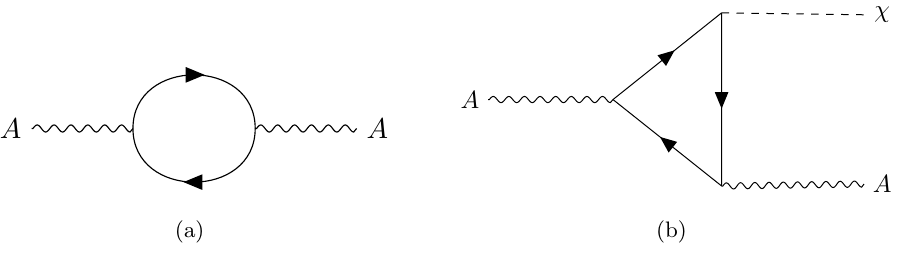
Figure 1 . One-loop diagrams contributing to the (cid:12)eld independent (a) and (cid:12)eld dependent (b) Chern- Simons terms in three